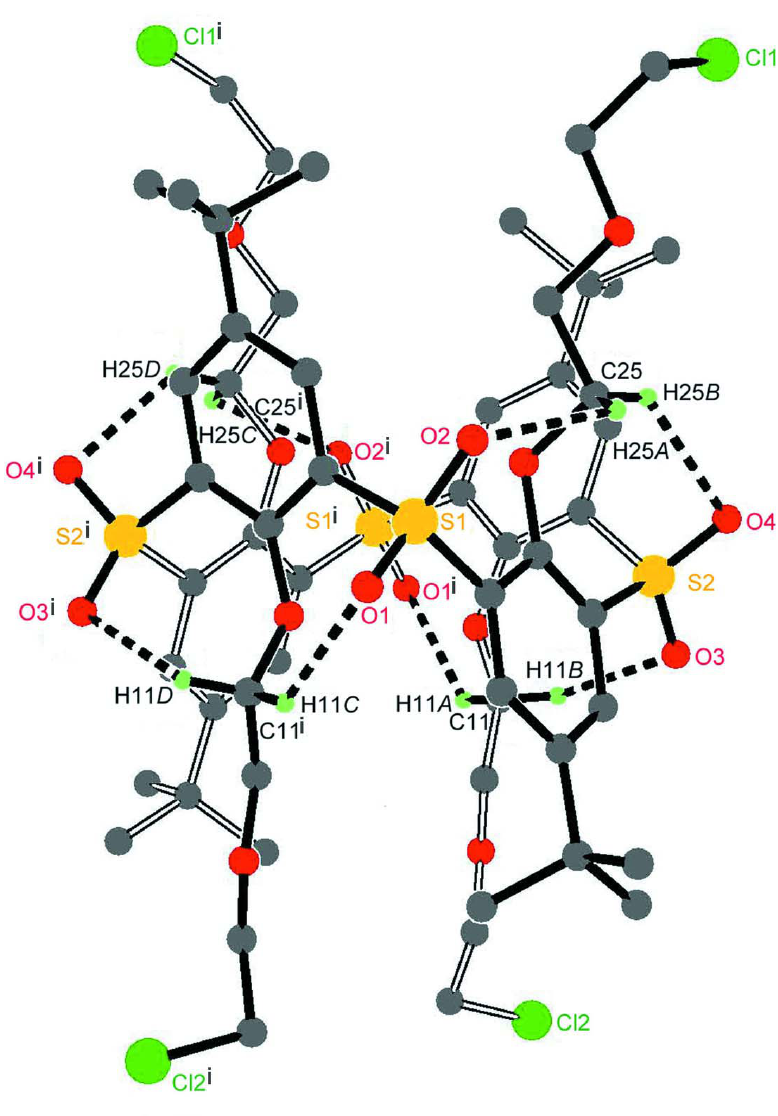
Figure 3 The array of intramolecular hydrogen-bonded rings of the title molecule viewed approximatively along the c axis. The minor disordered units and some hydrogen atoms are omitted for clarity. [Symmetry code: (i) - x + 1, y , - z +